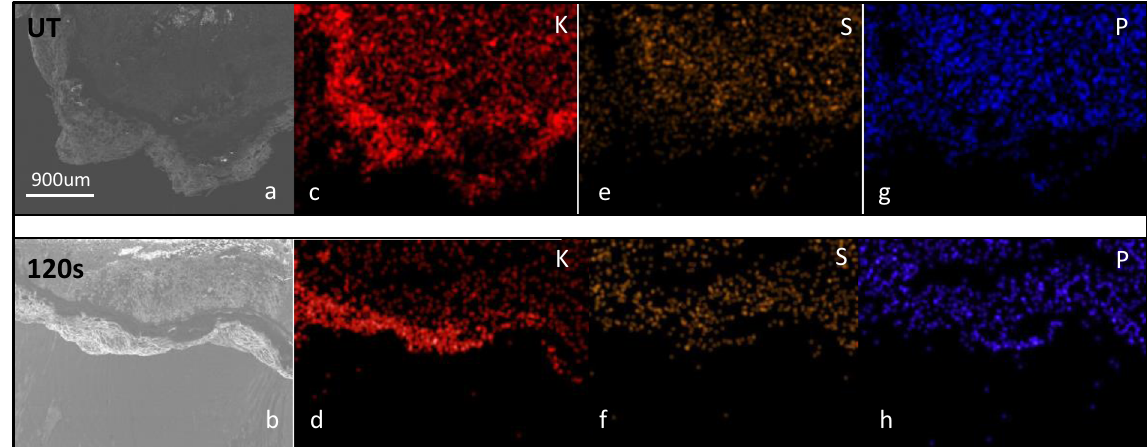
Figure 7. ( a , b ) Low magnification SEM micrographs of seed cuts before and after plasma exposure for 120 s. ( c – g ) EDX maps of the distribution of K, S and P before and after plasma treatments.